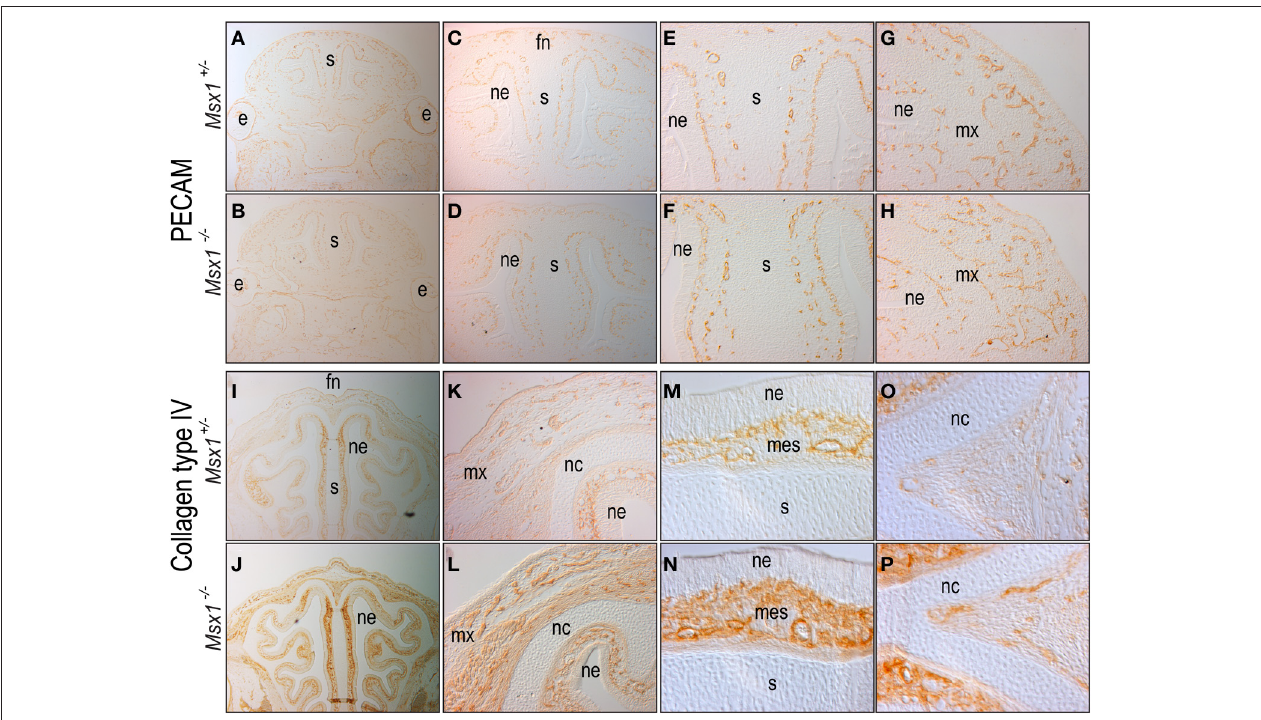
Type IV collagen in coronal sections of E15.5 (I,K,M,O) Msx1 + / − and (J,L,N,P) Msx1 − / − embryos in increasing magnifications: 5 × (I,J) , 10 × (K,L) , detailed nasal septum at 20 × (M,N) , and detailed nasal cartilage at 20 × (O,P) . e, eye; fn, frontonasal prominence; mes, mesenchyme; mx, maxillary prominence; nc, nasal cartilage; ne, nasal ectoderm; s, nasal